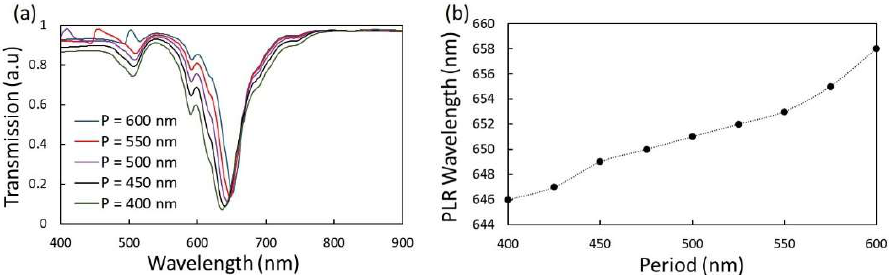
Figure 4. ( a ) The transmission spectra of Au nanoantennas on SiO 2 nanopillar arrays for different periods, for a geometry depicted in Figure 1. ( b ) PLR wavelength versus array period.